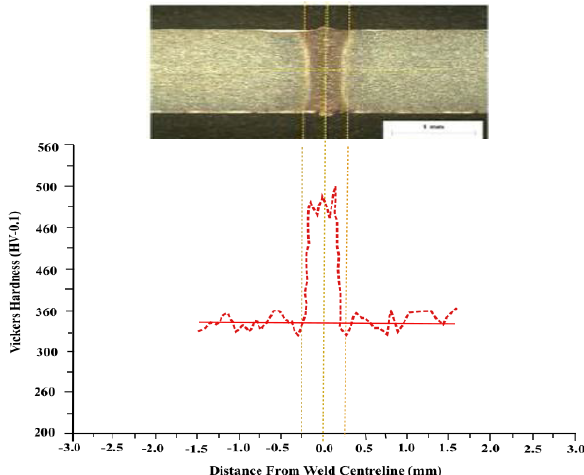
, (1) high 1 , (2) High heat 2